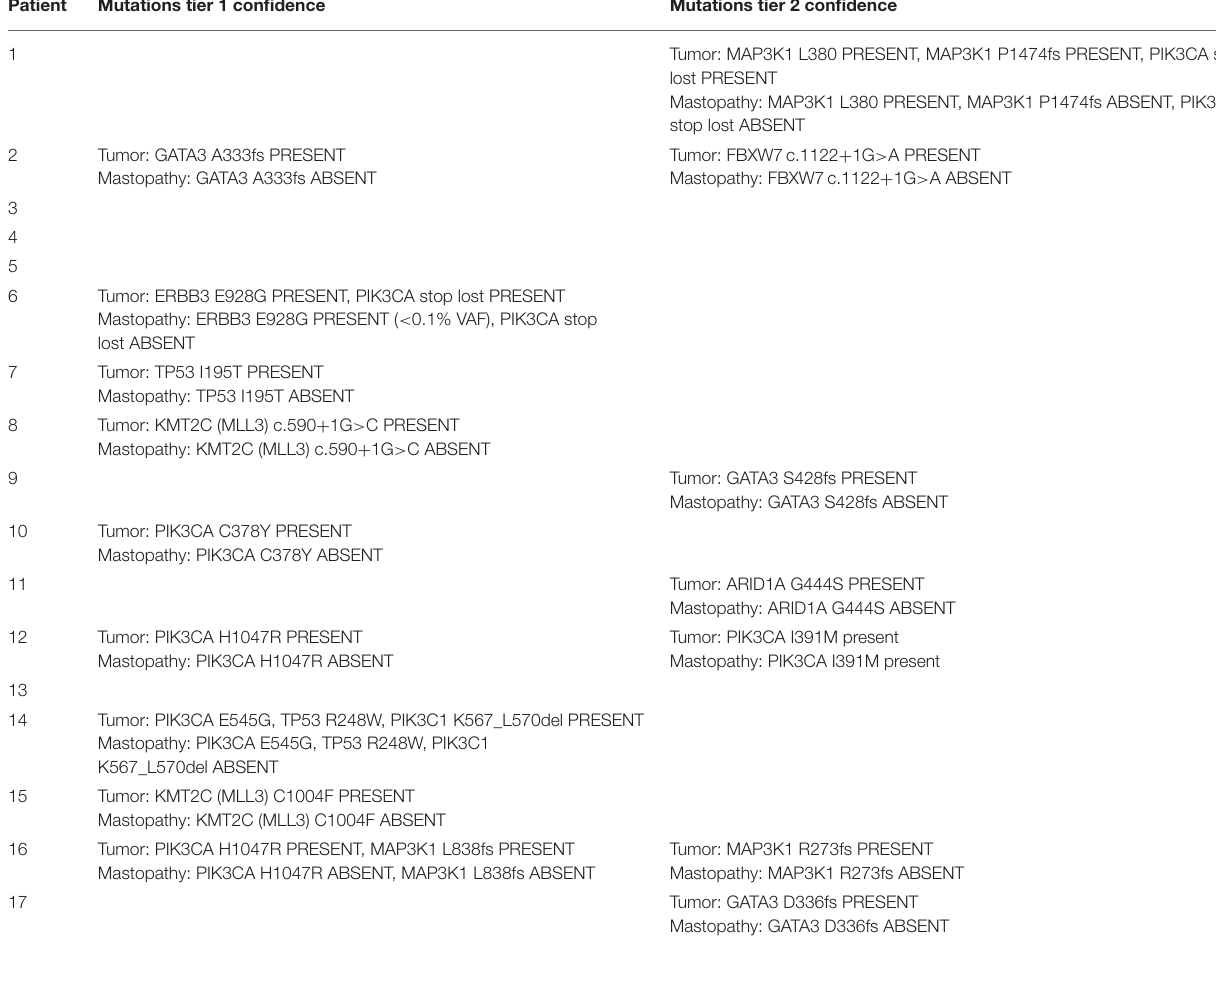
Patient Mutations tier 1 confidence Mutations tier 2